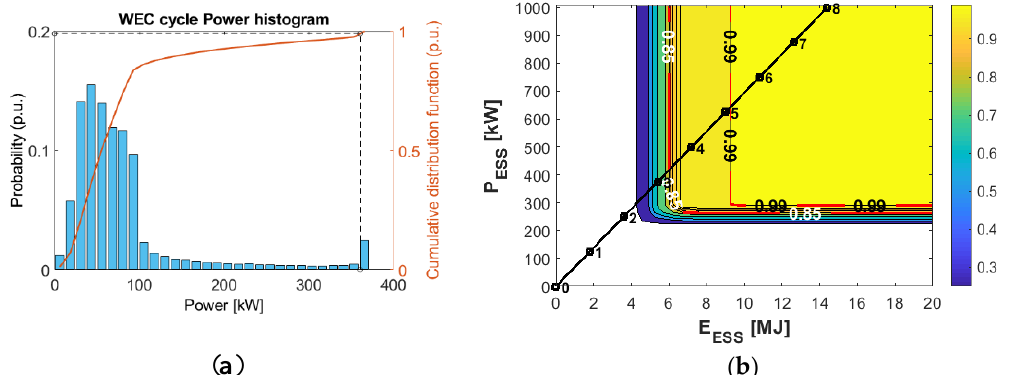
Figure 14. ( a ) Power histogram of the WEC Plant; ( b ) ESS power rating level and its useful energy with respect to the coverage level curves (the black line corresponds with the FESS module’s power–energy curve).